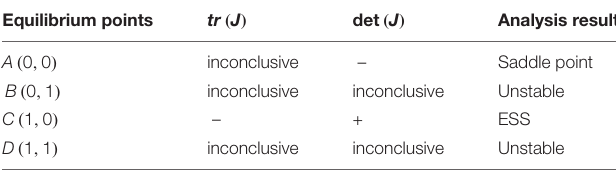
TABLE 7 | Local equilibrium stability analysis in case 3.